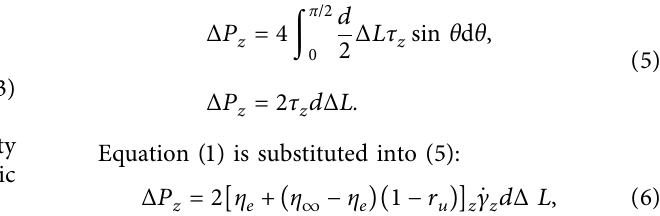
c c a and λ − a proposed by Seed max −